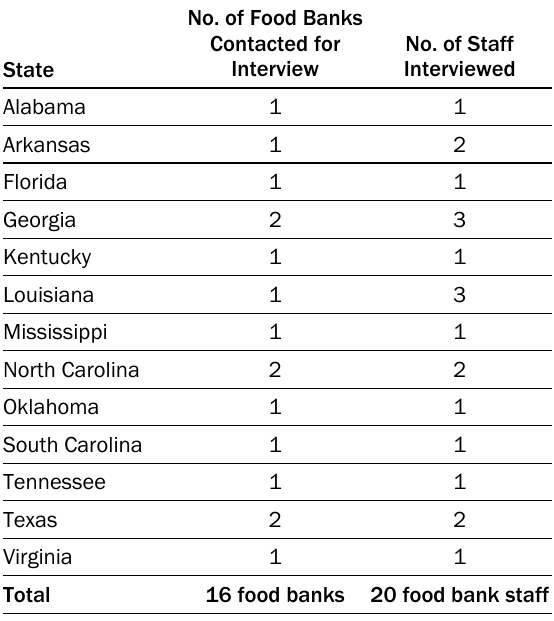
Table 1. List of Interviewees at Food Banks in the Target States